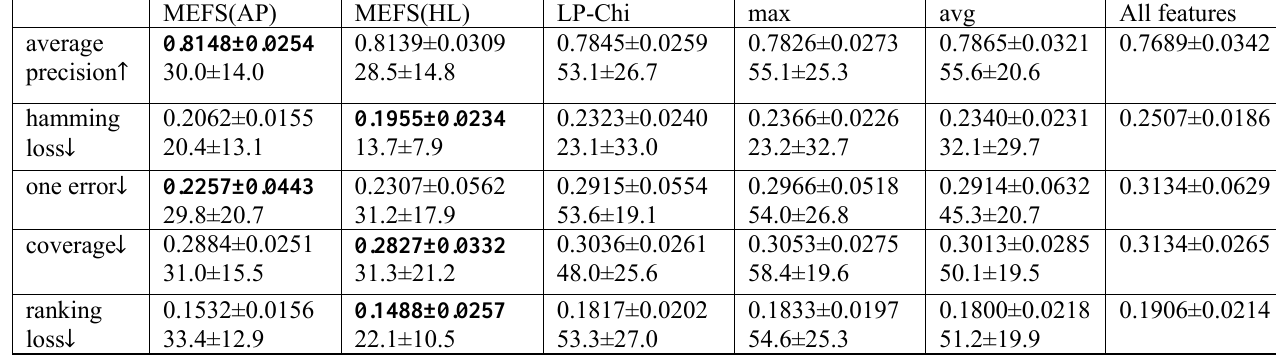
Table 5. Comparative results with MLNB